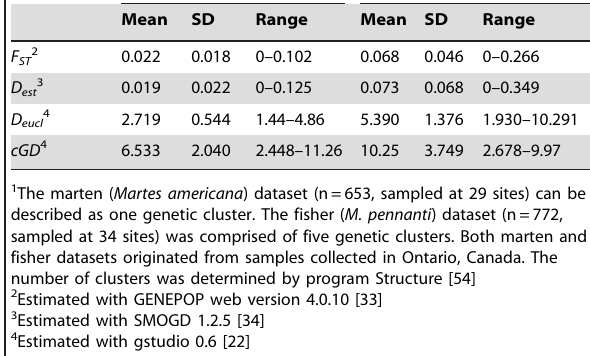
3 Estimated with SMOGD 1.2.5 [34] 4 Estimated with gstudio 0.6